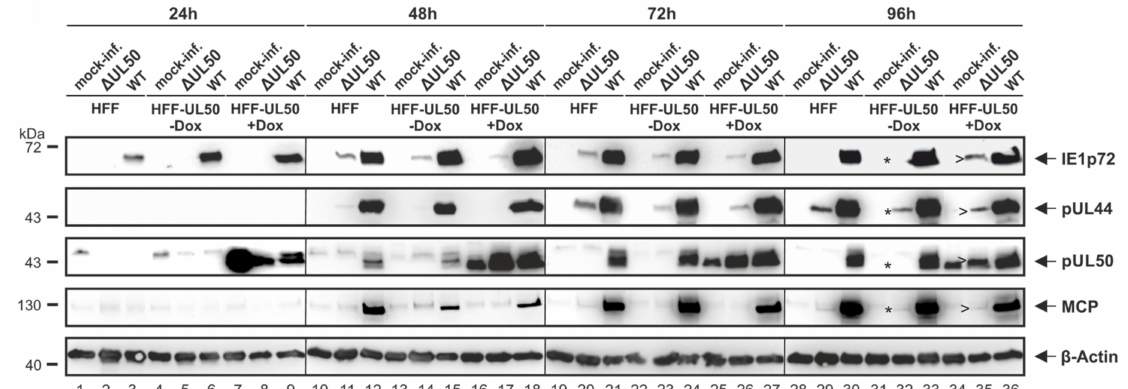
Figure 2. Analysis of viral protein expression of recombinant HCMV ∆ UL50. Normal HFFs were grown in 6-well plates (4 × 10 5 cells/well) and used for the production of primary infectious supernatants of parental HCMV AD169 (WT) and recombinant HCMV ∆ UL50. These supernatants were used as inocula (identical volumes of 1 mL/well) for the infection of normal HFF or HFF-UL50 − Dox/+Dox cells as indicated, to determine the expression patterns of HCMV WT in comparison to ∆ UL50. Protein expression was analyzed at the time points indicated (h p.i.) and Western blotting (Wb) was performed using the respective antibodies. Note the marked quantitative differences, i.e., the low level of infectivity and viral protein production, even after 96 h p.i., obtained with the ∆ UL50 inoculum, particularly in uninduced (*, − Dox) compared to pUL50-induced cells (>,